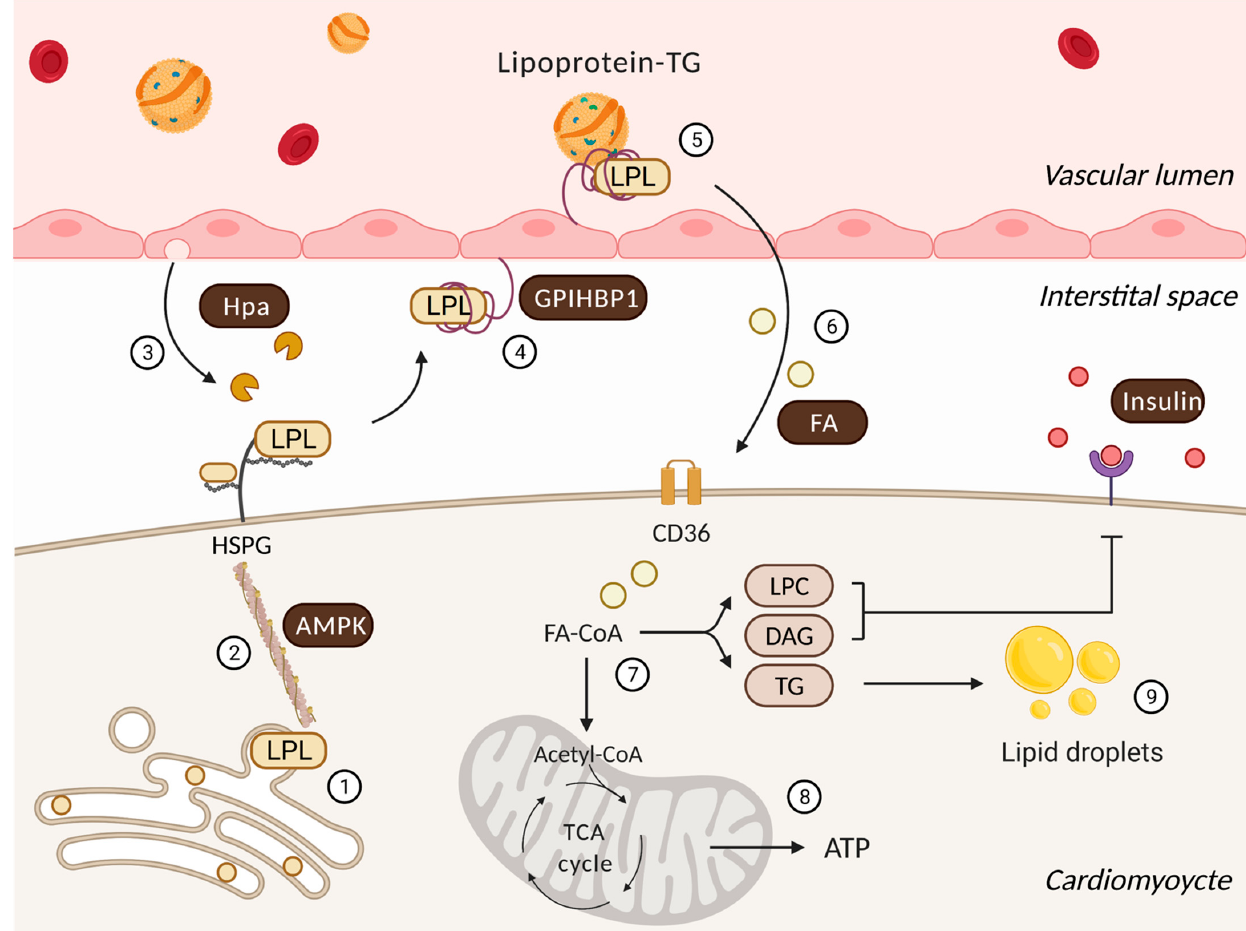
Figure 1. Regulatory processes that influence cardiac lipoprotein lipase action and the utilization of delivered FAs. Following its synthesis and activation in cardiomyocytes ( 1 ), the actin cytoskeleton traffics LPL to myocyte cell surface HSPG under the control of AMPK ( 2 ). Onward progress is facilitated by heparanase (Hpa) secreted from the endothelial cell that cleaves HSPG side chains to liberate LPL ( 3 ). GPIHBP1 captures this interstitial LPL and relocates it from the basolateral to the apical side of endothelial cell ( 4 ). At this location, a GPIHBP1 platform and LPL enables lipoprotein-TG hydrolysis to generate FAs ( 5 ) that are delivered to the cardiomyocyte ( 6 ). In the cardiomyocyte, FAs have two major fates ( 7 ). They can either undergo mitochondrial beta-oxidation and oxidative phosphorylation to generate ATP ( 8 ) or accumulate as lipid metabolites/droplets ( 9 ). Lipid intermediates are known to effect insulin signaling and substrate utilization. LPC: lysophosphatidylcholine; DAG: diacylglycerol.